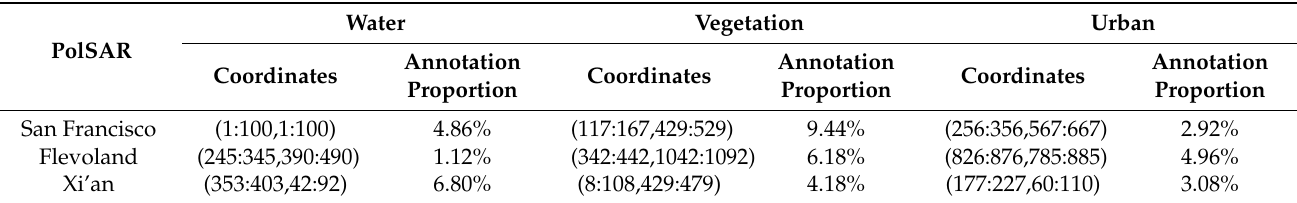
Table 1. Big Blocks for Different Categories in Multi-PolSAR images.